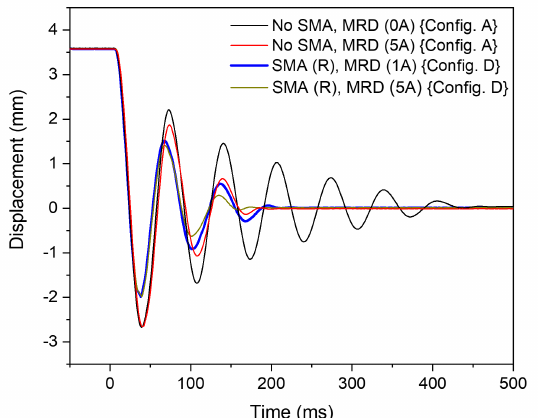
Figure 18. The displacement behaviour with respect to time allowing for the comparison of damping performance of hybrid SMA–MR damper (‘Config. D’) with the MR damper (‘Config. A’) for a loading amplitude of 3.6 mm utilizing the maximal energy dissipation of the SMA